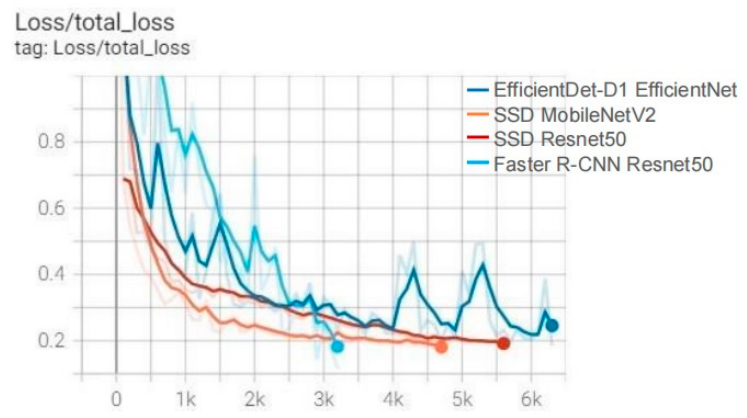
Figure 7. The total loss of each model during the training process.